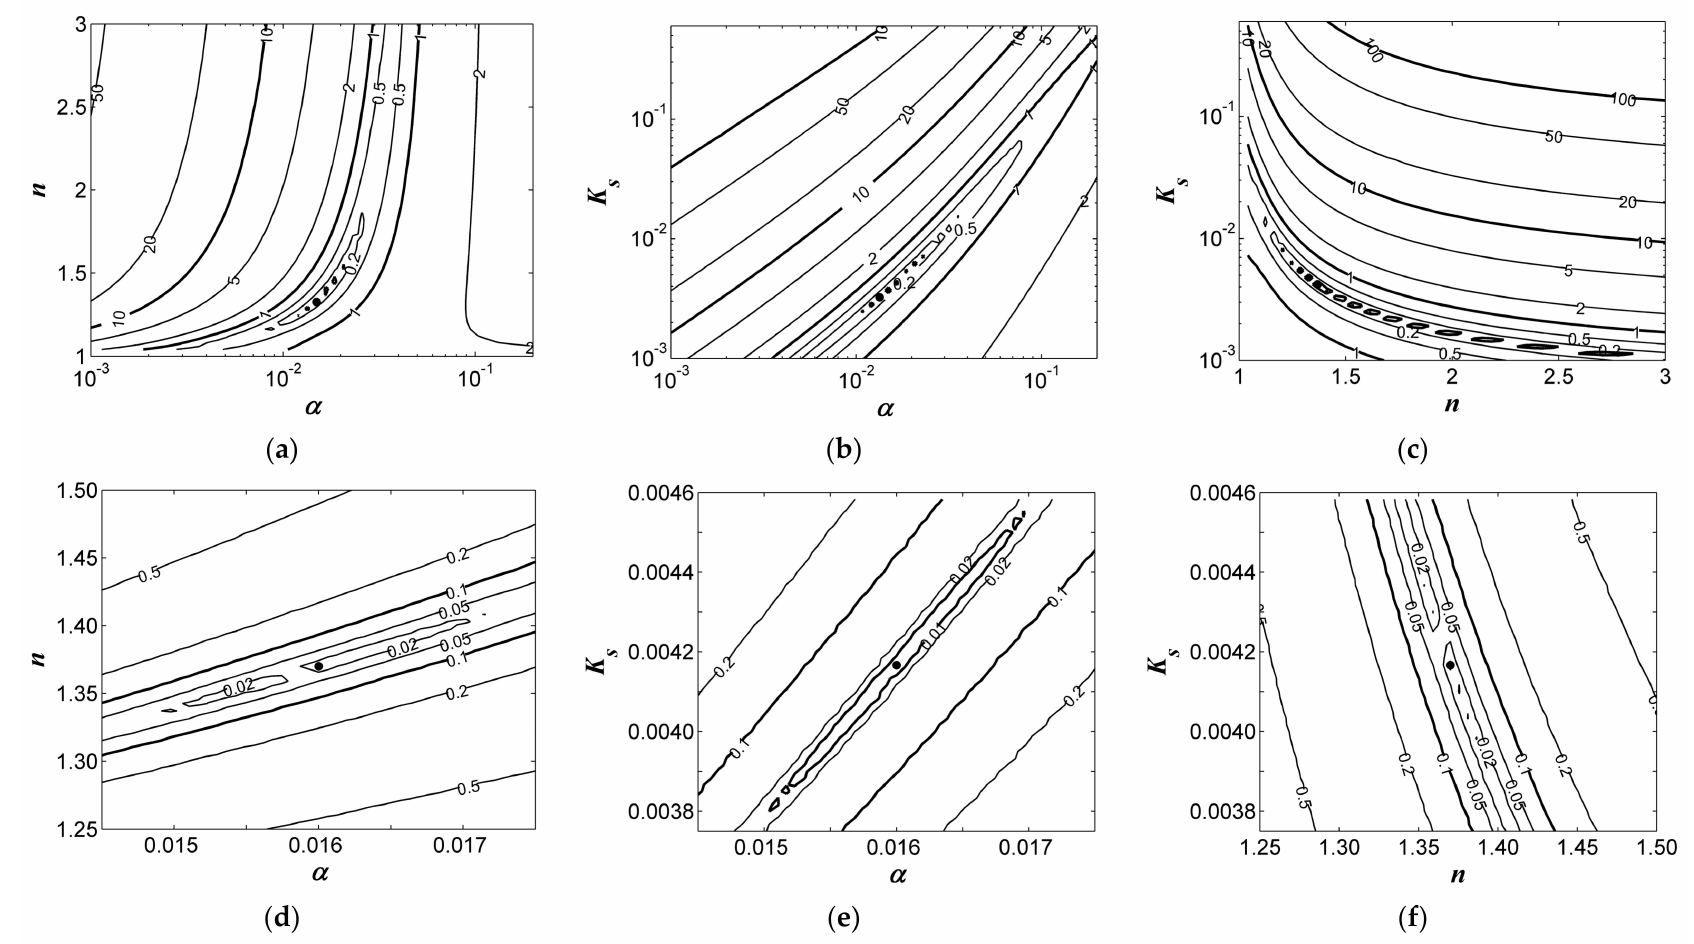
Figure 6. Contours (in detail) of objective function ψ ( Q ) of silt under θ initial equal to a 40% effective saturation degree. The hydraulic parameters of silt: θ r = 0.034 cm 3 cm − 3 ; θ s = 0.46 cm 3 cm − 3 ; α = 0.016 cm − 1 ; n = 1.37; K s = 0.0042 cm min − 1 . Results are plotted in the: ( a , d ) α – n ; ( b , e ) α – K s ; and ( c , f ) n – K s parameter planes. ( a – c ) depict the global scale, while ( d – f ) depict the local scale near the minimum. The solid circles are the true